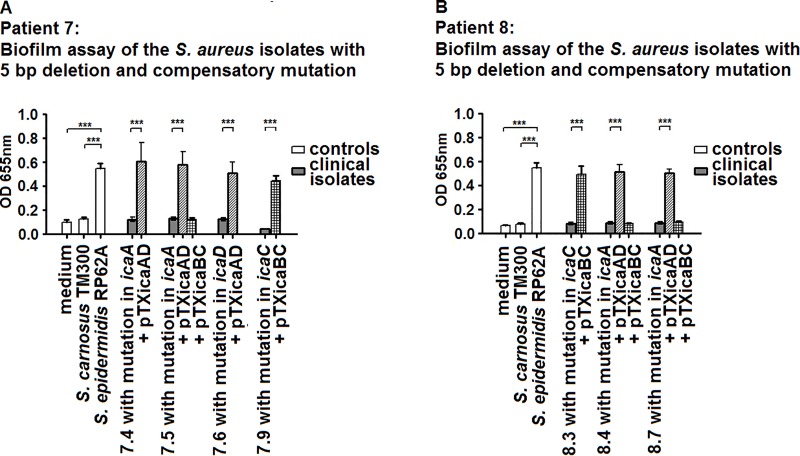
Biofilm formation of isolates with 5 bp deletion, compensatory mutations, which were complemented with the wild-type ica genes.Biofilm formation of the strains with compensatory mutations in icaA, icaD or icaC was abrogated. A) Isolates of patient 7. B) Isolates of patient 8. Transformation with a vector expressing the appropriate wild-type ica gene conferred biofilm formation.